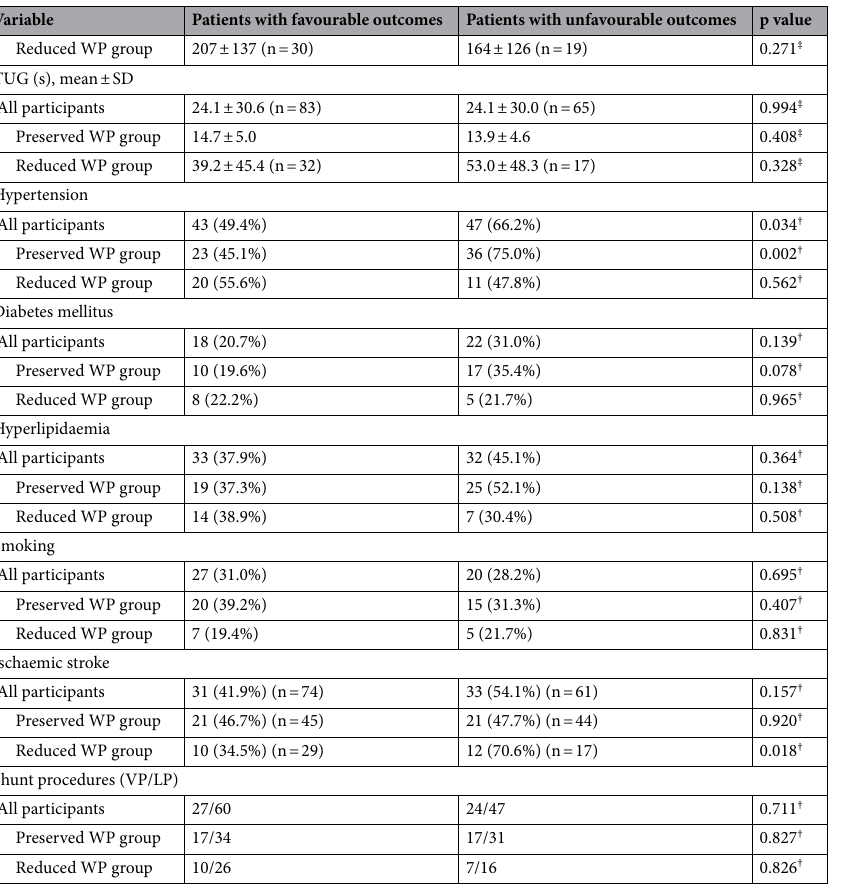
Table 2. Clinical differences between the patients with favourable and unfavourable outcomes. FAB Frontal Assessment Battery, iNPH idiopathic normal-pressure hydrocephalus, iNPHGS idiopathic